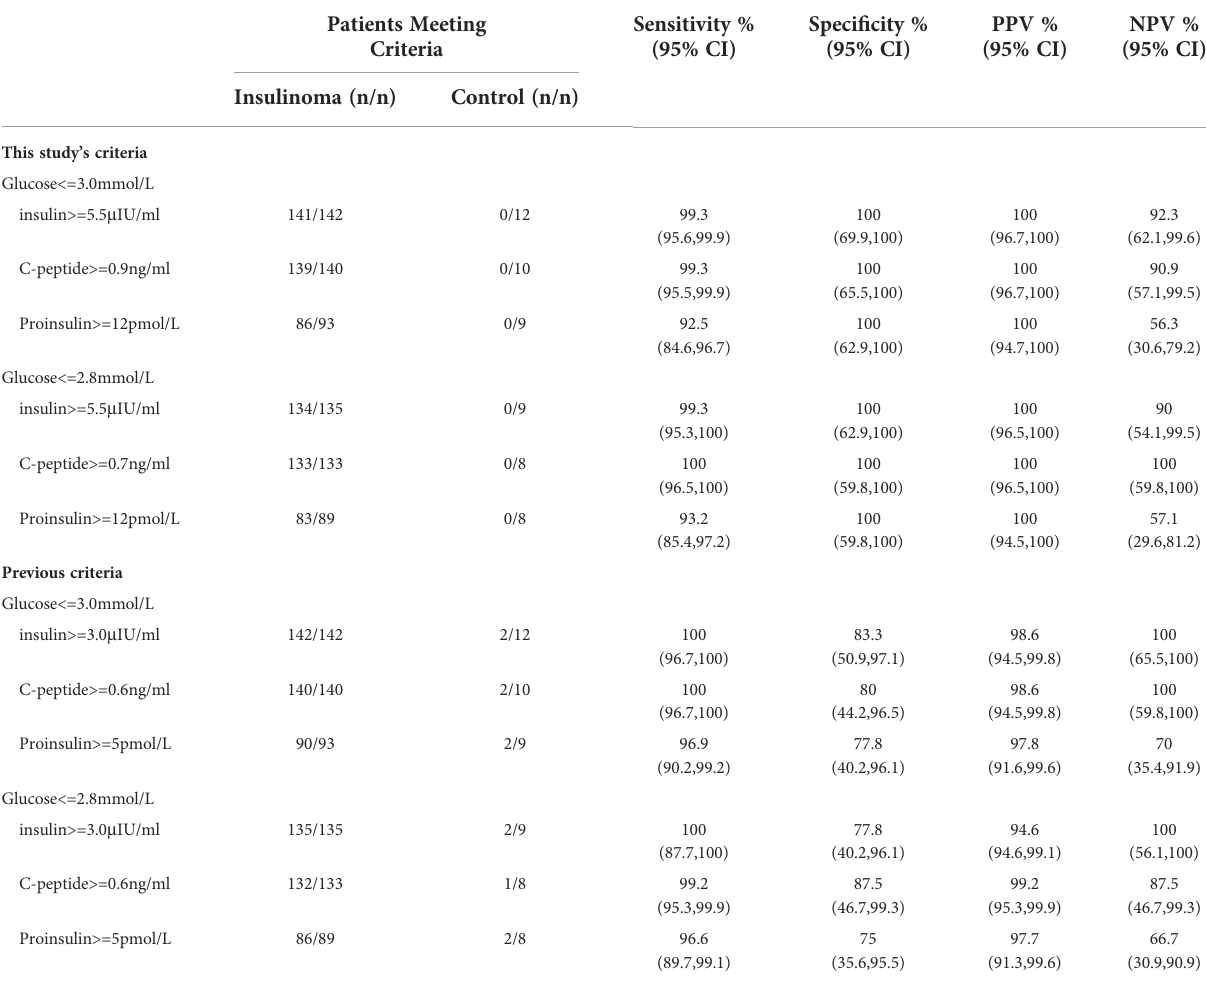
TABLE 2 Diagnostic performance of new criteria in our study and previous criteria based on Western populations with concomitant blood glucose below 2.8 or